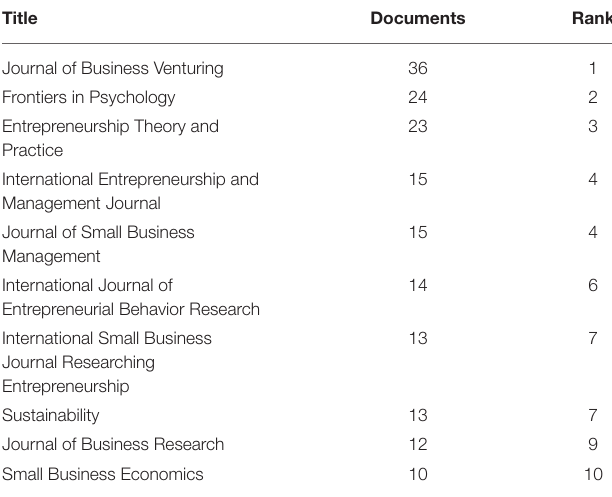
TABLE 1 | Top 10 journals in number of